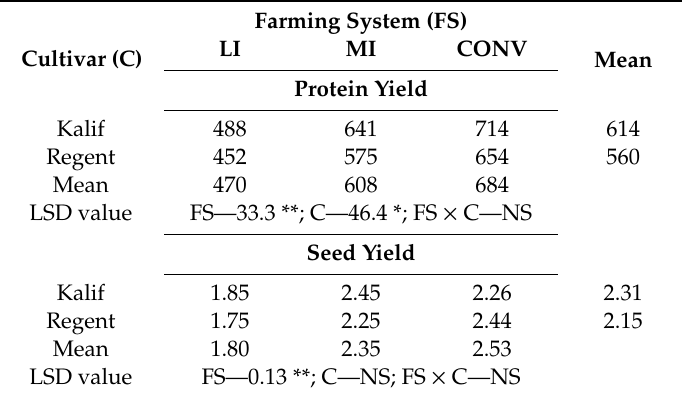
Table 5. Narrow-leaved lupin protein yield (kg ha –1 ) and seed yield (t ha –1 ).